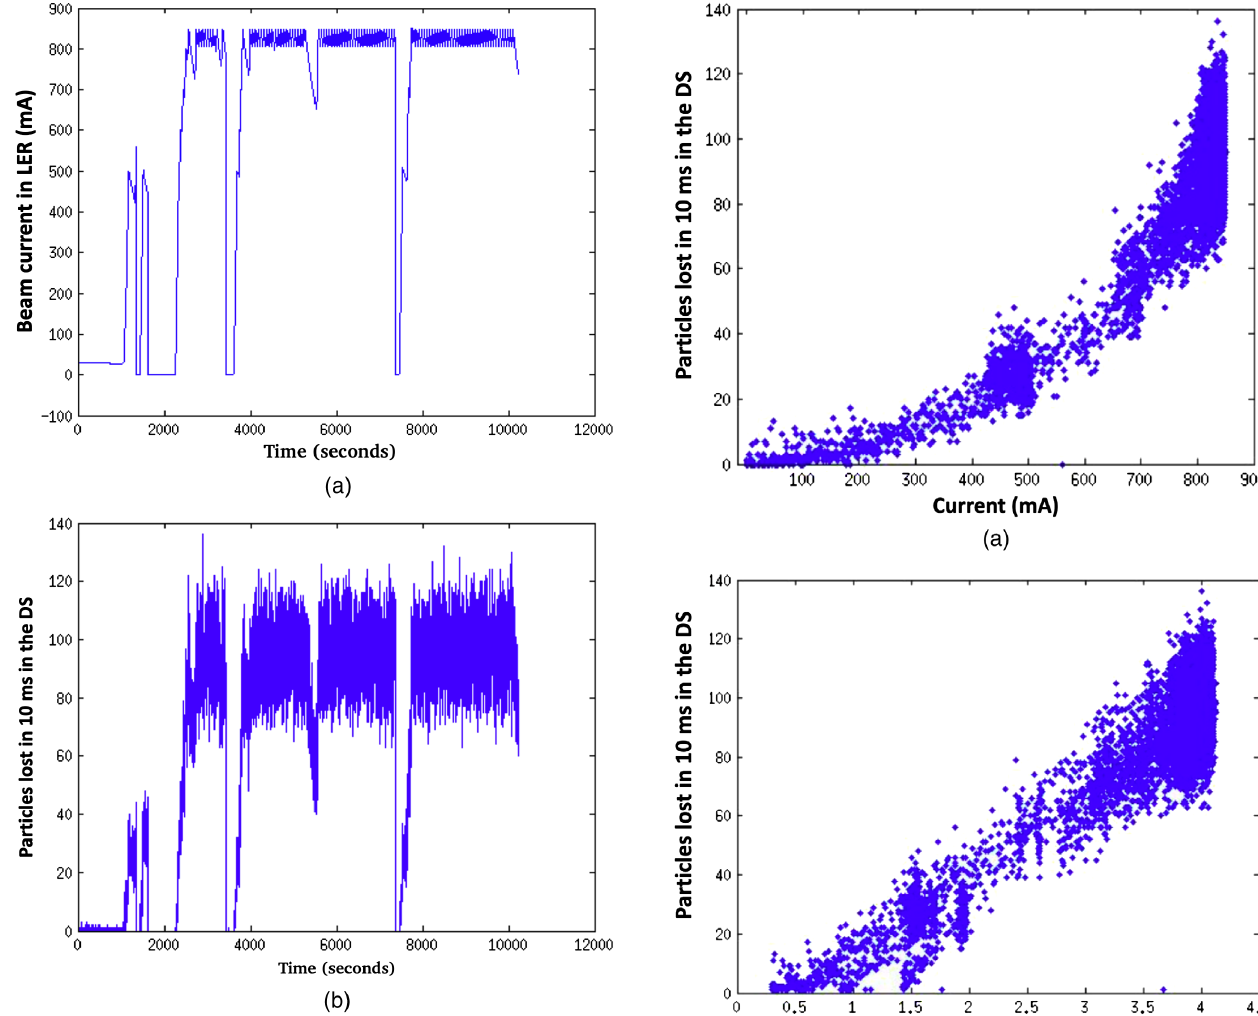
FIG. 14. (a) The beam current in the LER as function of time and (b) the loss rate measured by the sCVD in 10 ms over the same time period.